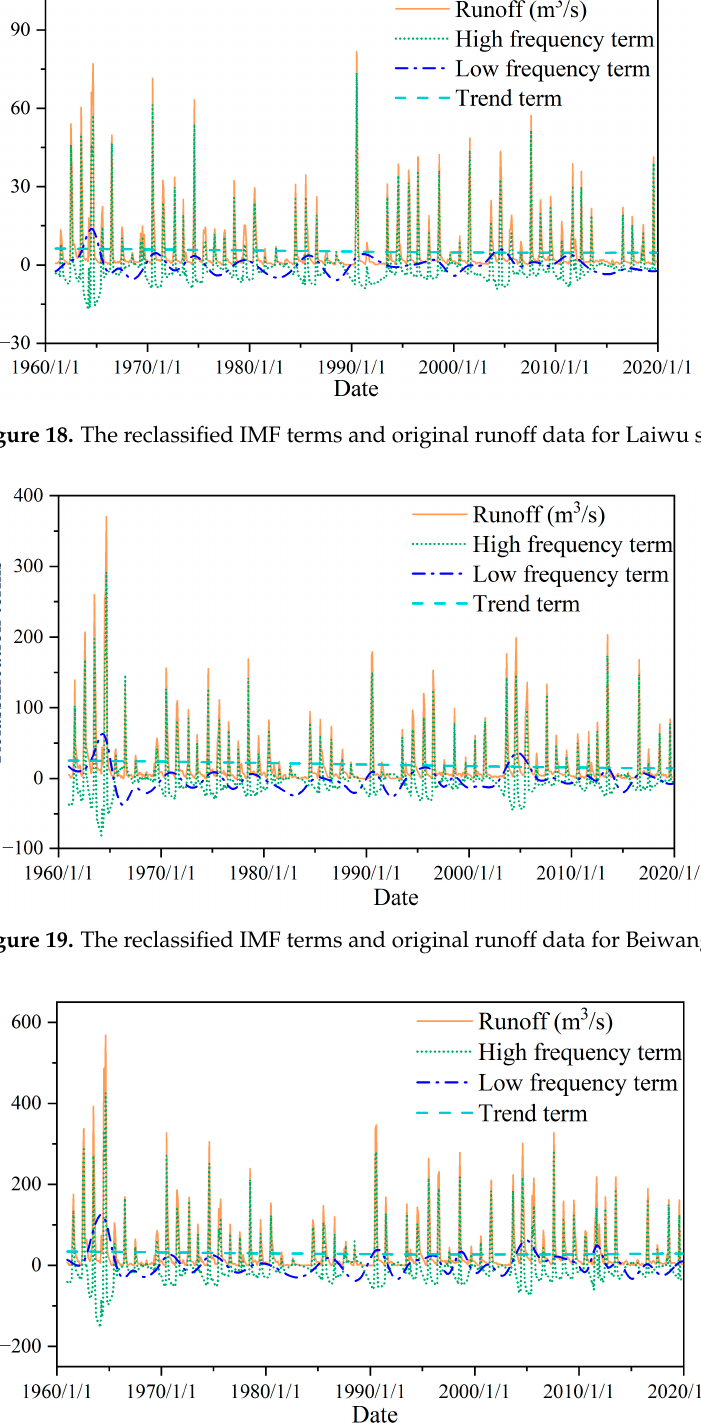
Figure 21. The reclassified IMF terms and original runoff data for Daicunba station. 4. Conclusions In this study, the trends, mutations, and periodicity of the runoff in the Dawen River Basin were analyzed, and the runoff was decomposed and reclassified. The dynamic evolution of the runoff under changing environments was explored using various methods. (1) Tendency analysis The intra-annual distribution of the runoff in the Dawen River Basin was uneven. The annual runoff, the wet season runoff, and the dry season runoff for all hydrological stations presented a downward trend, and the runoff decreased continuously from upstream to downstream. The runoff in the early years of the study period (1961–1969) was relatively high in each chronological analysis. The dynamics and magnitude of the annual runoff and the wet season runoff remained similar, while the dry season runoff rates differed. The changes in runoff indicated that under environments of climate change, human activities have a greater impact on runoff. (2) Mutation analysis From upstream to downstream, the annual, wet season, and dry season runoff for Laiwu hydrological station showed mutations in 1975–1976. The annual runoff, wet season, and dry season runoff at Beiwang Hydrological Station mutated in 1980. The annual and wet season runoff at Dawenkou Hydrological Station mutated in 1975–1976, while the dry season runoff mutated in 2003. The annual and wet season runoff at Daicunba Hydrological Station mutated in 1975–1976, while the dry season runoff